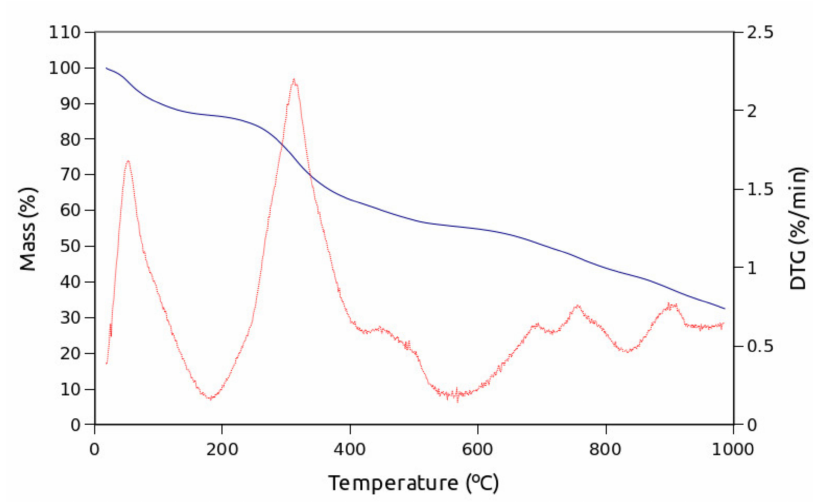
Figure 1. TG and DTG plots obtained from a 10 ºC/min linear heating ramp of lignin.